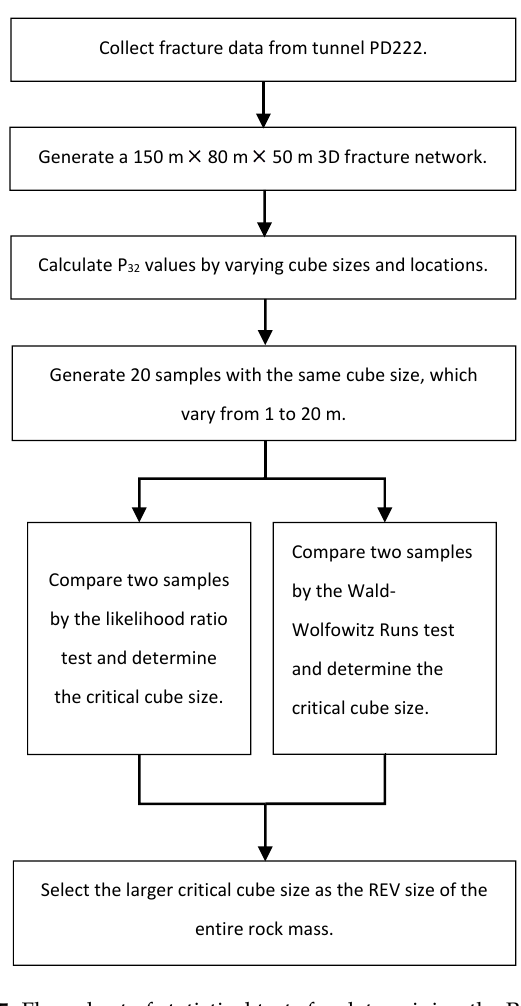
Figure 5. Flow chart of statistical tests for determining the REV size.